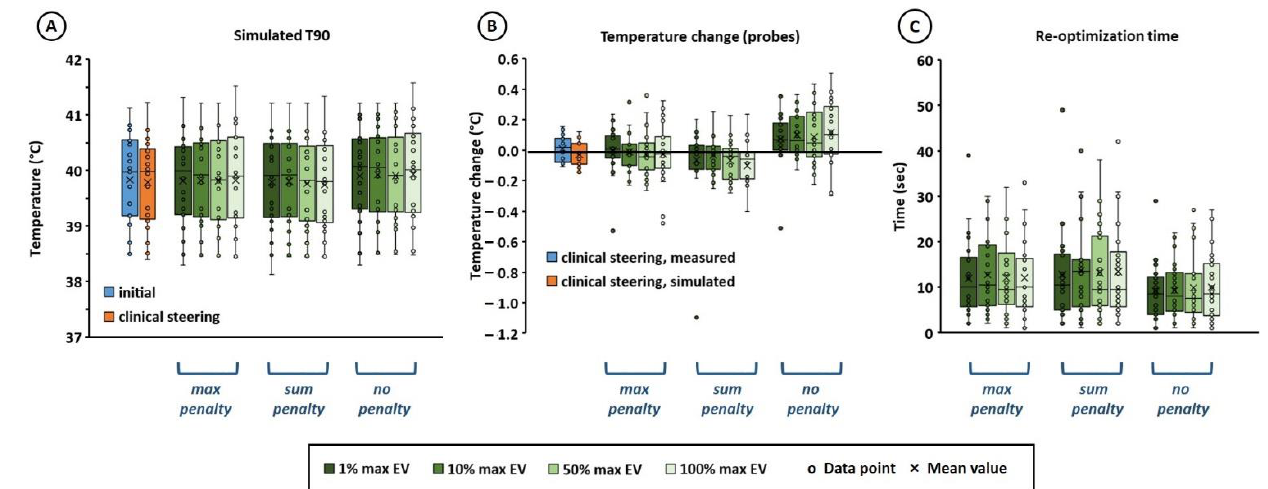
Figure 3. Effect of different re-optimization strategies on the simulated T90 ( A ) and the temperature change along the thermometry probes ( B ). The re-optimization calculation time per strategy is indicated in ( C ) for an Intel Xeon ® E5-1650 v3 3.5 GHz running CentOS 6.8. Results are compared to simulations for the clinically applied protocol/experience-based steering strategy during treatment ( A , B ), as well as to probe measurements ( B ). Max penalty, sum penalty and no penalty refer to the re-optimization goal functions in equations (3), (4) and (5), respectively. To efficiently calculate a hot spot temperature during optimization, the average temperature of the voxels with the x% largest heating potential was calculated, which are the voxels with the largest maximum eigenvalues (EV) of their temperature matrix ( T in Equation (2). Values of x of 1, 10, 50 and 100% were evaluated. The hot spot diameter was 5 cm.